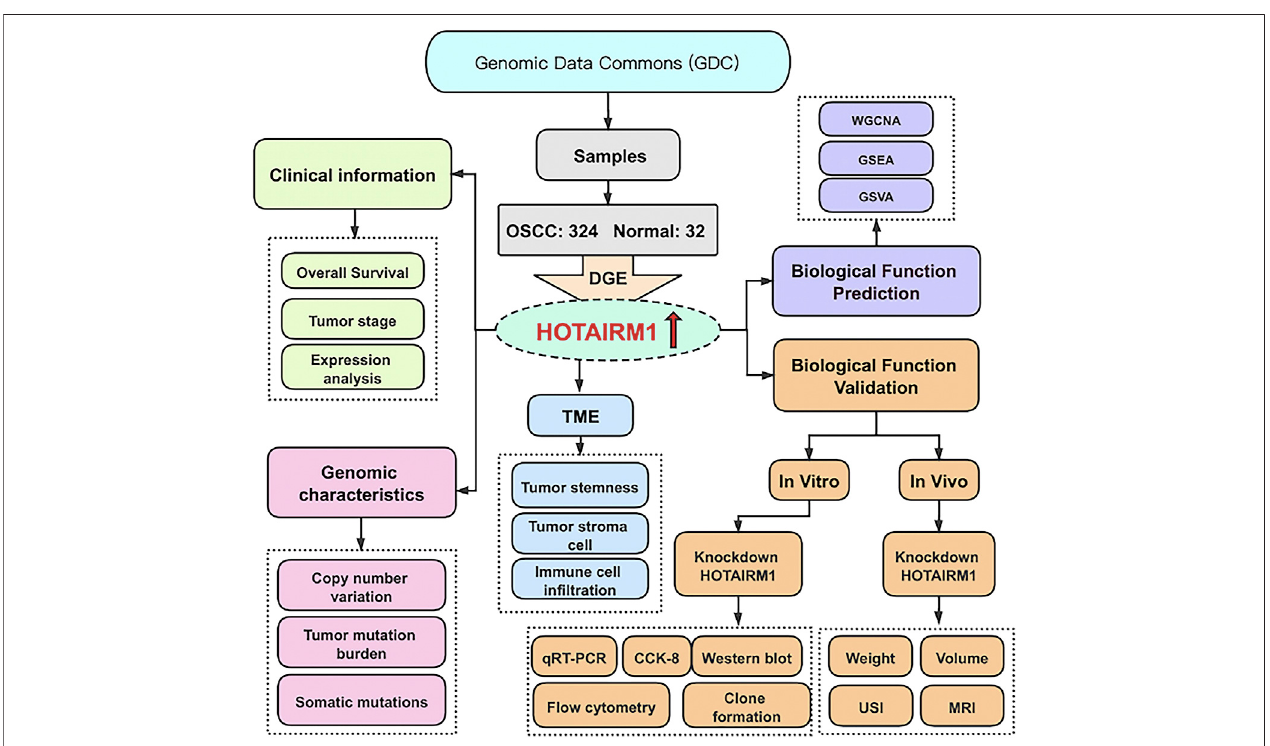
FIGURE 1 | The fl owchart of this